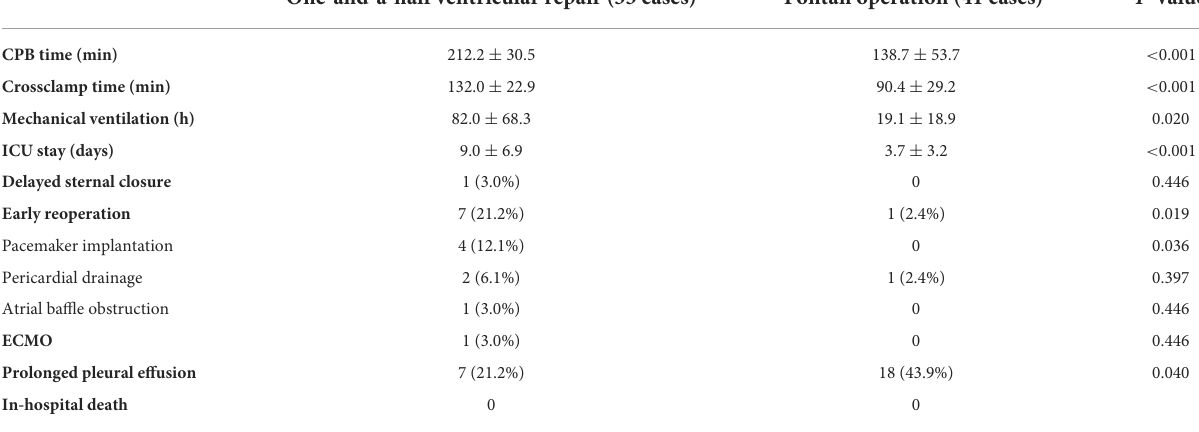
TABLE 2 Perioperative outcomes. One-and-a-half ventricular repair (33 cases)